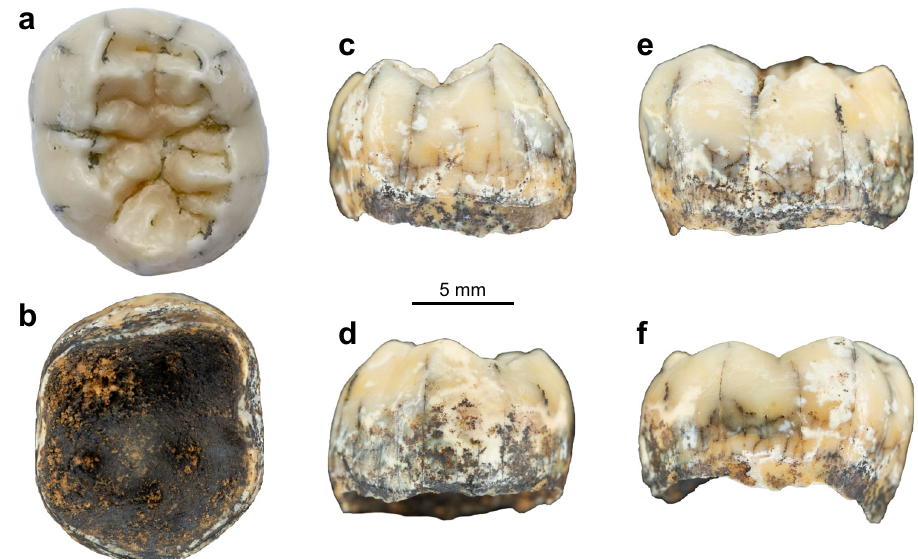
Fig. 2 Views of the TNH2-1 specimen. Pictures of TNH2-1 in occlusal ( a ), inferior ( b ), mesial ( c ), distal ( d ), buccal ( e ) and lingual ( f )